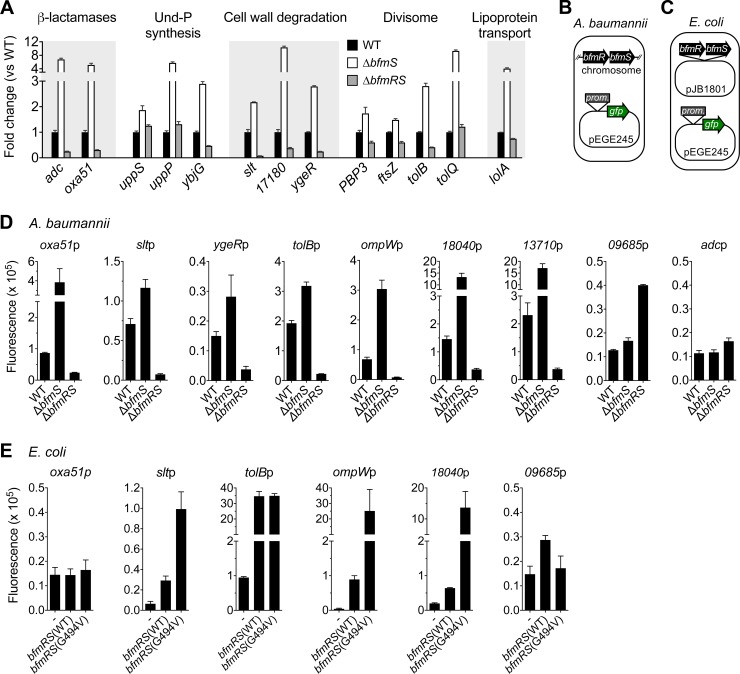
Transcriptional regulation by BfmRS assessed by qRT-PCR and reporter analysis.(A) RNA from the indicated strains was reverse-transcribed and probed via qPCR with primers specific for genes encoding proteins linked to the indicated functional category. Shown is the mean of the fold change in transcript levels (vs WT) ± s.d. (n = 3). For each gene, P < 0.02 in unpaired t-tests comparing mutant vs WT. 17180 denotes ACX60_RS17180, a predicted lytic transglycosylase. (B-E) Analysis of BfmRS control of gene expression by using transcriptional reporter fusions. Strains were grown to early post-exponential phase, and reporter activity measured in microtiter format (Materials and methods). (D) A. baumannii strains 17978 (WT), EGA195 (ΔbfmS), or EGA495 (ΔbfmRS) contained a derivative of plasmid pEGE245 encoding GFP transcriptional fusions to the promoter regions upstream of the indicated gene, as diagramed in panel B. 18040, 13710, and 09685 denote ACX60_RS18040, ACX60_RS13710, and ACX60_RS09685, respectively. (E) E. coli DH5α harbored pEGE245 reporter derivatives as well as compatible plasmid pJB1801 containing no additional gene (-) or the indicated bfmRS allele, as diagramed in panel C. Reporter fluorescence was calculated as the fluorescence units/A600 of the reporter bacteria minus the fluorescence units/A600 of control bacteria containing vector alone. Bars show mean ± s.d. (n = 3). In unpaired t-tests comparing mutant vs WT (D) or bfmRS allele vs vector alone (E), P < 0.04 for each comparison except for: adcp [ΔbfmS vs WT], oxa51p [bfmRS vs vector and bfmRS(G494V) vs vector], and 09685p [bfmRS(G494V) vs vector] (P >0.5).